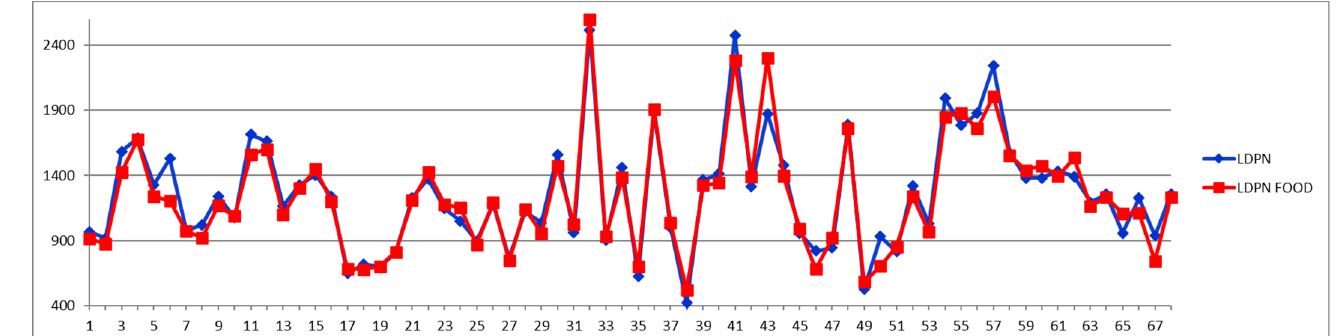
Figure 8. Total LDL particle number (LDPN) (nmol/L) in fasting (blue) and postprandial (red) status for control cases (1–29) and CVD cases (30–68).